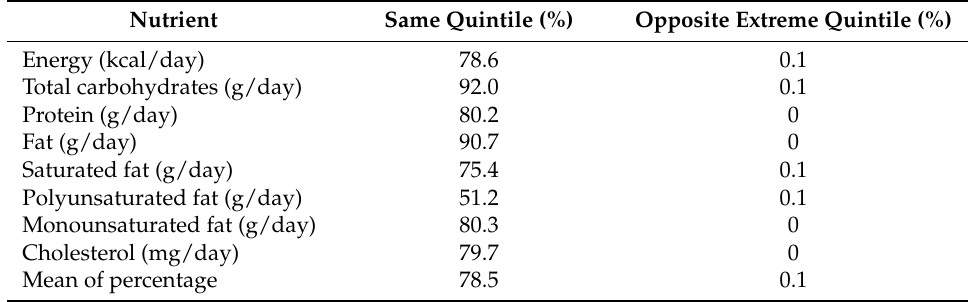
Table 4. Quintile agreement and extreme quintile disagreement percent between recomputed and original nutrient intakes ( n =